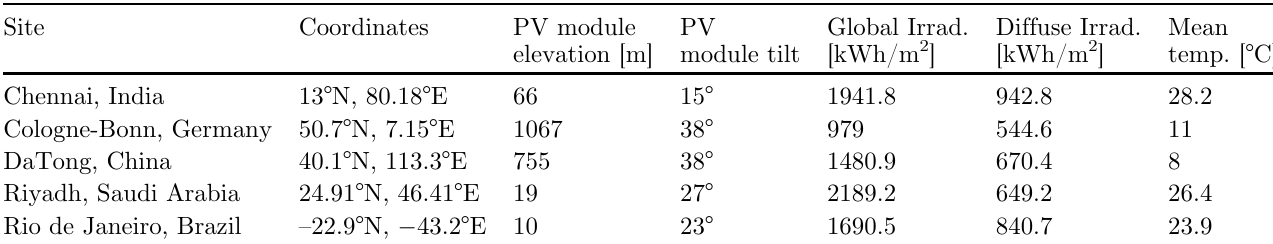
Table 1. Summary of test sites and abstract information used in speci fi c energy yield comparison.